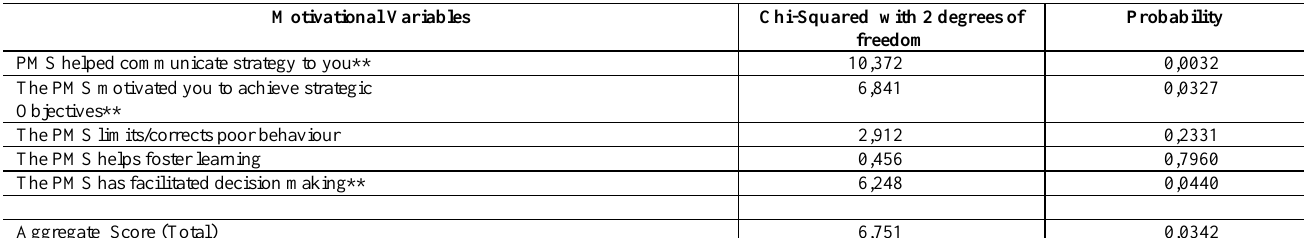
Table 6: Significance of difference of opinions (Kruskal-Wallis tests) Motivational